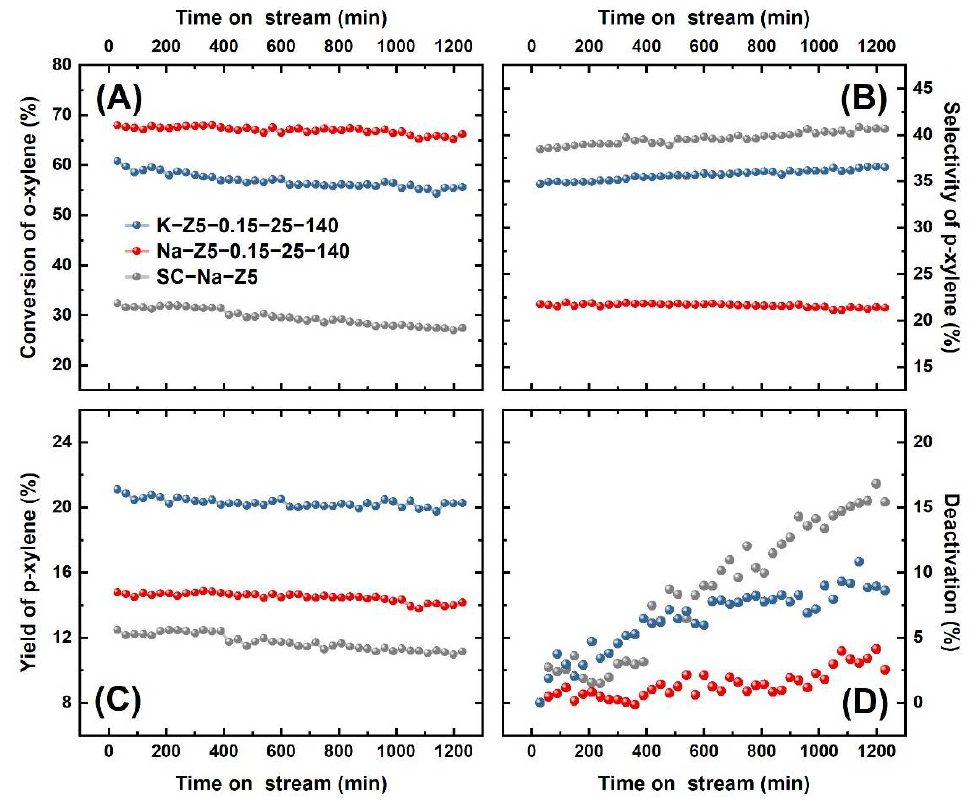
Figure 6. ( A ) Conversion of o -xylene, ( B ) selectivity of p -xylene, ( C ) yield of p -xylene and ( D ) deactivation of catalysts over three typical ZSM-5 mesocrystals. The deactivation is defined as (X 0 − X)/X 0 , where X 0 is the initial o -xylene conversion and X is the o -xylene conversion at time